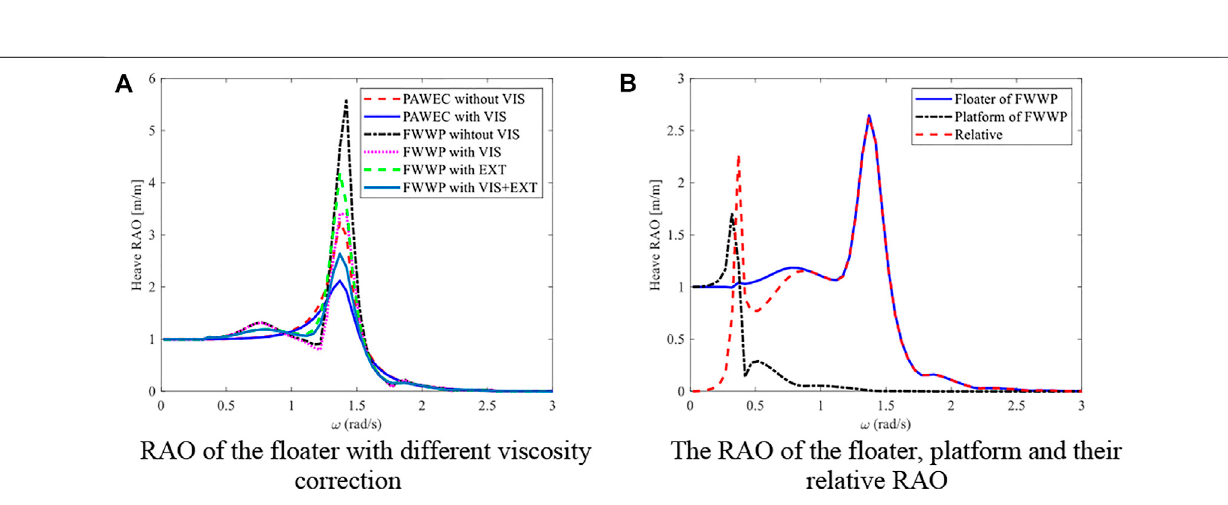
Frontiers in Energy Research |